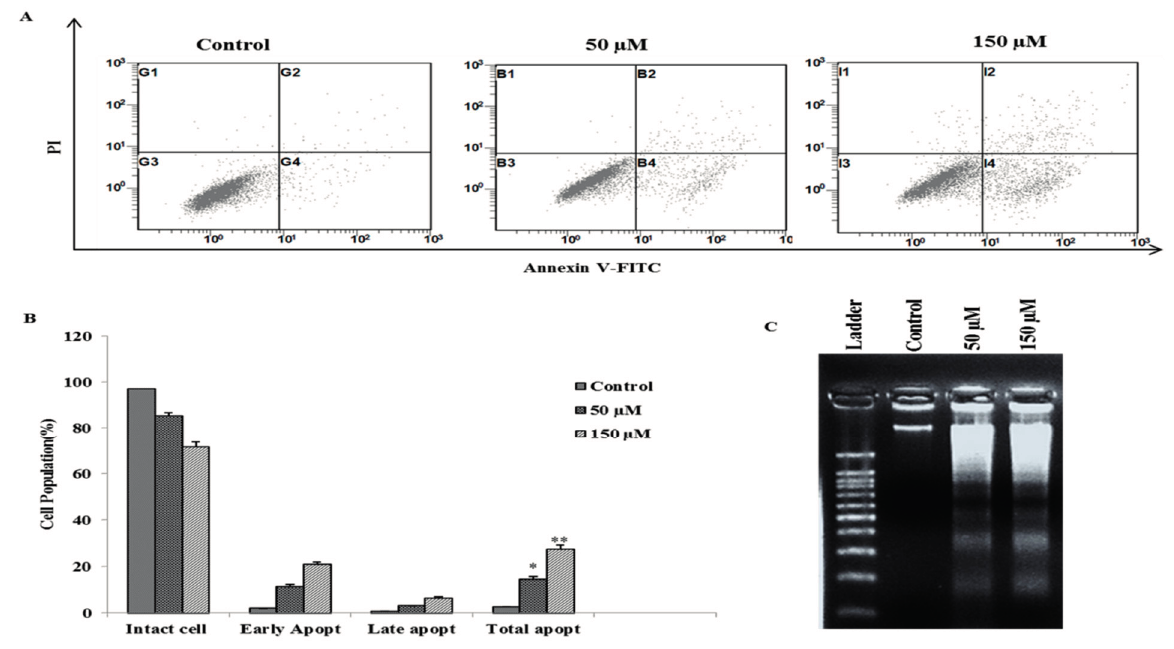
Figure 3. Poncirin induces dose dependent apoptosis in AGS cells. AGS cells were incubated at indicated concentrations of Poncirin for 24 h. ( A , B ) Annexin V-Propidium Iodide staining followed by apoptosis detection by flow cytometry; and ( C ) DNA fragmentation test of untreated and Poncirin-treated AGS cells indicates internucleosomal cleavage associated with apoptosis. The data are shown as means ± SD of three independent experiments (* p < 0.05 and ** p < 0.01 vs.